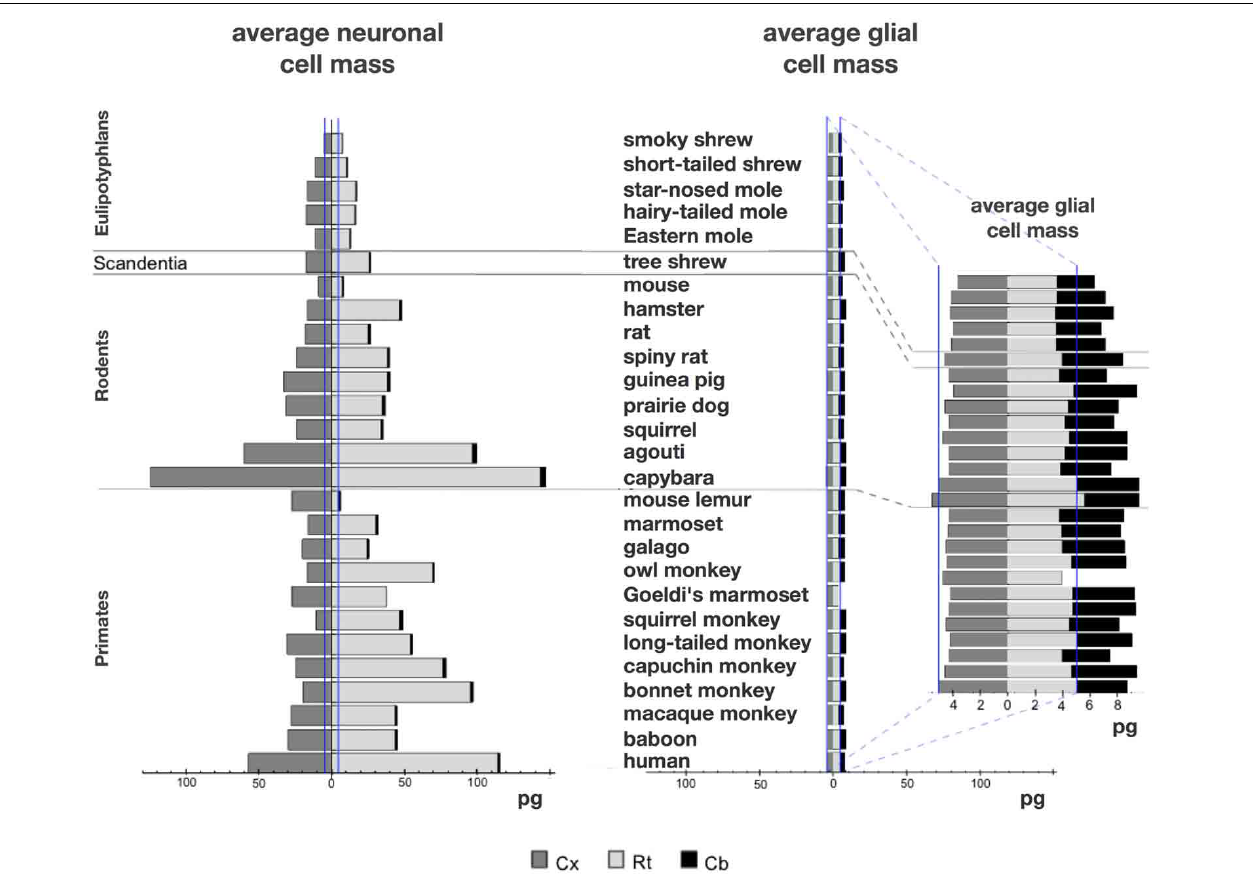
FIGURE 6 | Large variation in average neuronal cell mass, but not in average glial cell mass. Main figure, horizontal bars (stacked, non-overlapping) indicate estimated average neuronal (left) and glial (right) cell mass in the cerebral cortex (dark gray), cerebellum (black) and rest